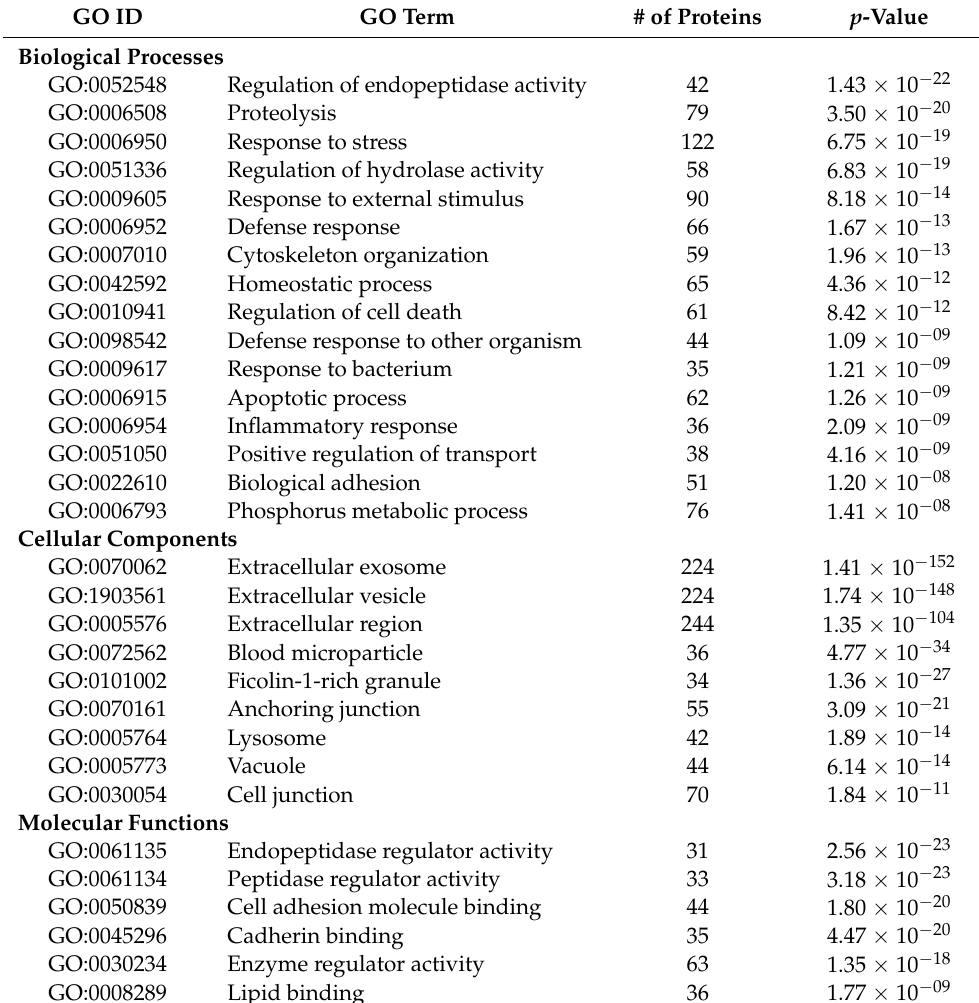
Table 5. Gene Ontology (GO) enrichment analysis of selected tear